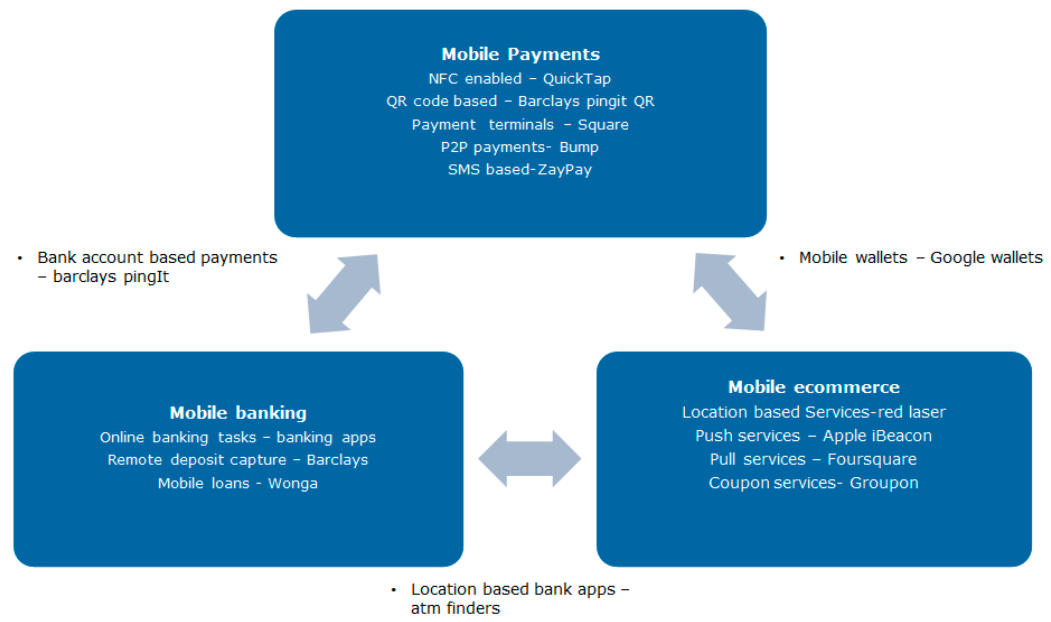
Figure 3. Mobile payments services (m-payments) ecosystem of UK.